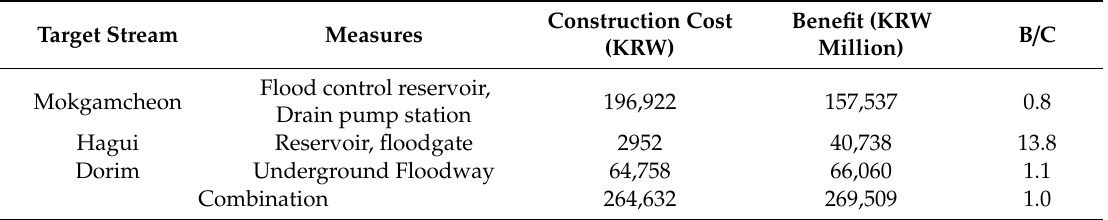
Table 7. Comparative optimal